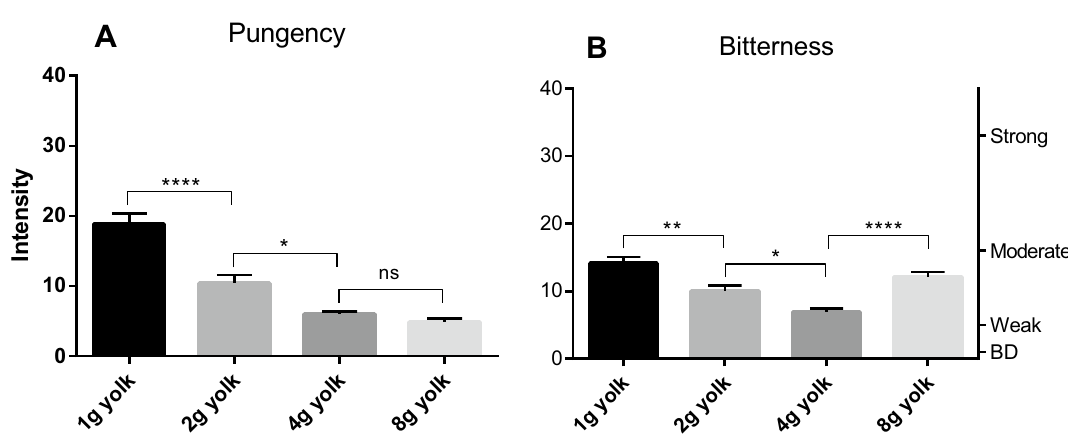
Figure 3. Perceived throat pungency ( A ) and bitterness ( B ) from 3 egg yolk free model mixtures made with 3 different oils and a surfactant blend: HO (High Oleic acid Safflower oil) mixture, LOC (EVOO low in OC) mixture and HOC (EVOO high in OC) mixture. The right axis displays the corresponding portion of the LMS scale used by participants to provide their ratings (BD = barely detectable). 10 subjects (4 females and 6 males; average age 28) rated each sample 4 times in random order. Data are represented as mean + /- SEM. Statistics: ns = not significant; * p < 0.05; ** p < 0.005; *** p < 0.001; **** p < 0.0001.